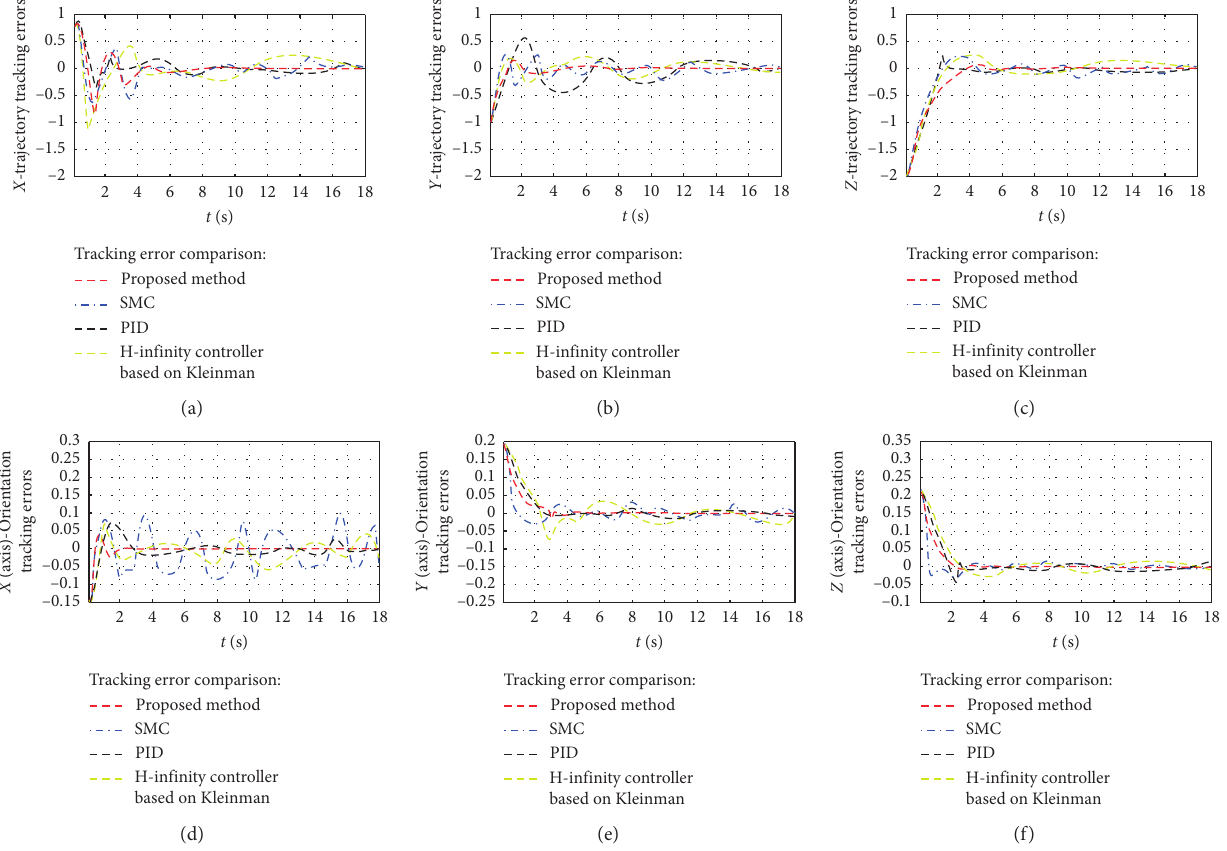
controller based on ∞